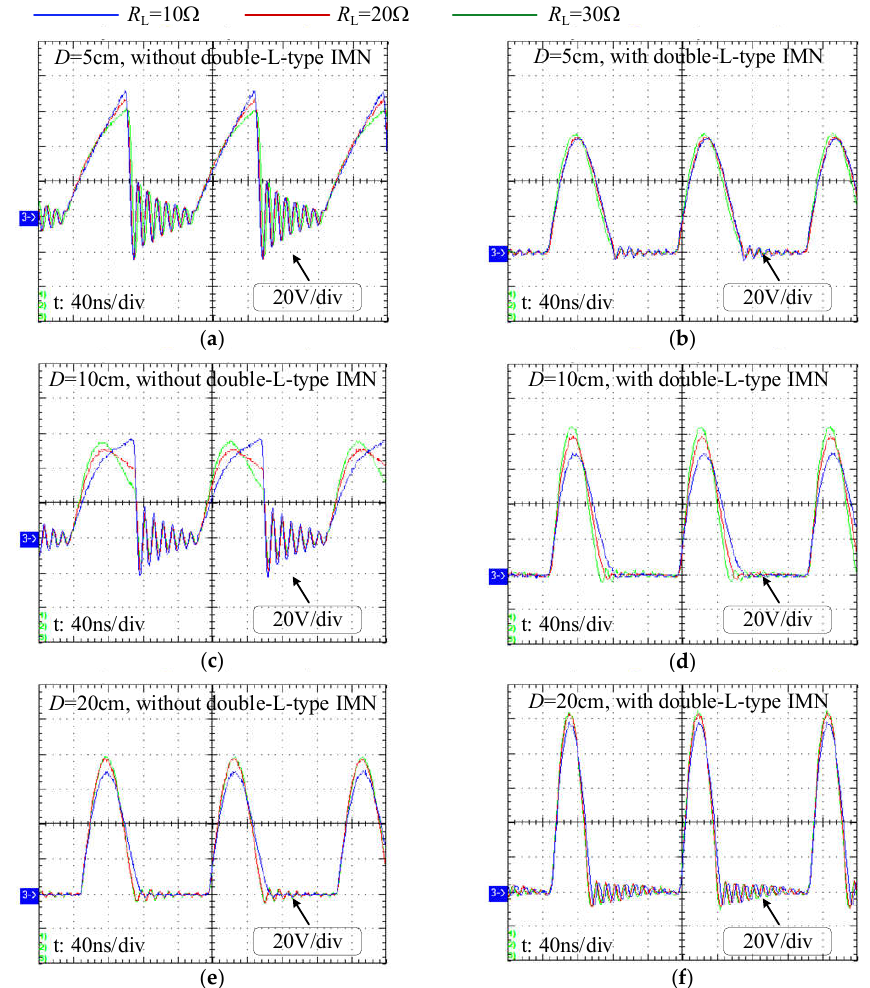
Figure 10. Drain voltage V DS of Class-E PA without/with double-L-type IMN under various coil distances D and loads R L : ( a , b ) D = 5 cm; ( c , d ) D = 10 cm; ( e , f ) D = 20 cm.